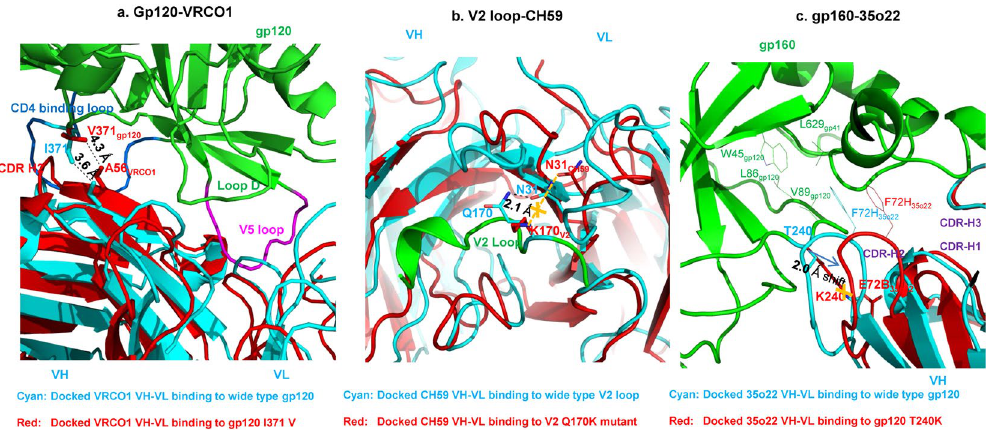
Figure 4. Molecular docking results showed the impact of adaptive mutations of HIV-1 Env on the binding ability of bnAbs. ( a ) VRC01 was colored in cyan in the docked VRC01 VH-VL binding to wild-type gp120 and colored in red in the docked VRC01 VH-VL binding to gp120 I371 V. ( b ) CH59 was colored in cyan in the docked CH59 VH-VL binding to wild-type gp120 V2 loop and colored in red in the docked CH59 VH-VL binding to gp120 V2 Q170K mutant. ( c ) 35O22 was colored in cyan in the docked 35O22 VH-VL binding to wild-type gp120 and colored in red in the docked 35O22 VH-VL binding to gp120 T240K